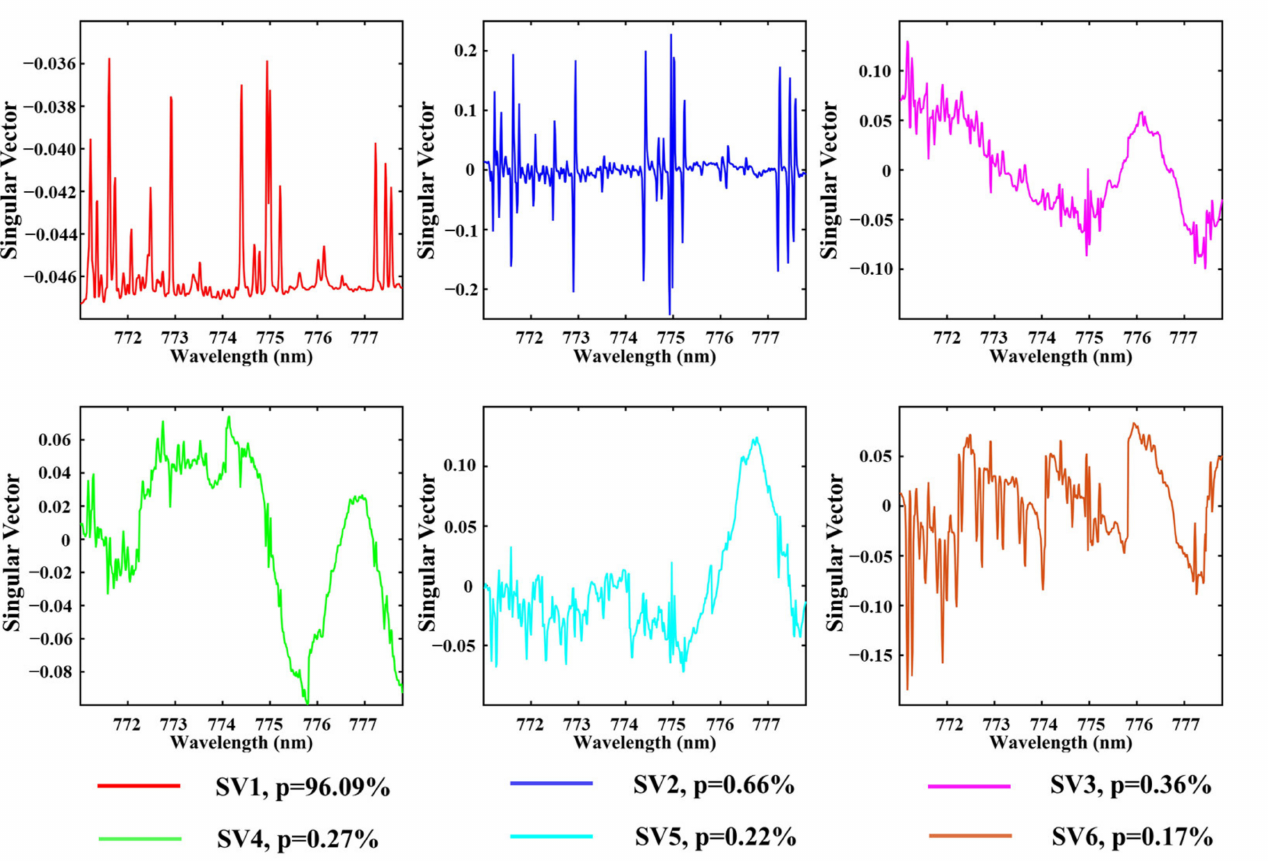
Figure 1. The first six SVs derived from the training set, p refers to the contribution of each ν to the total variance of the training